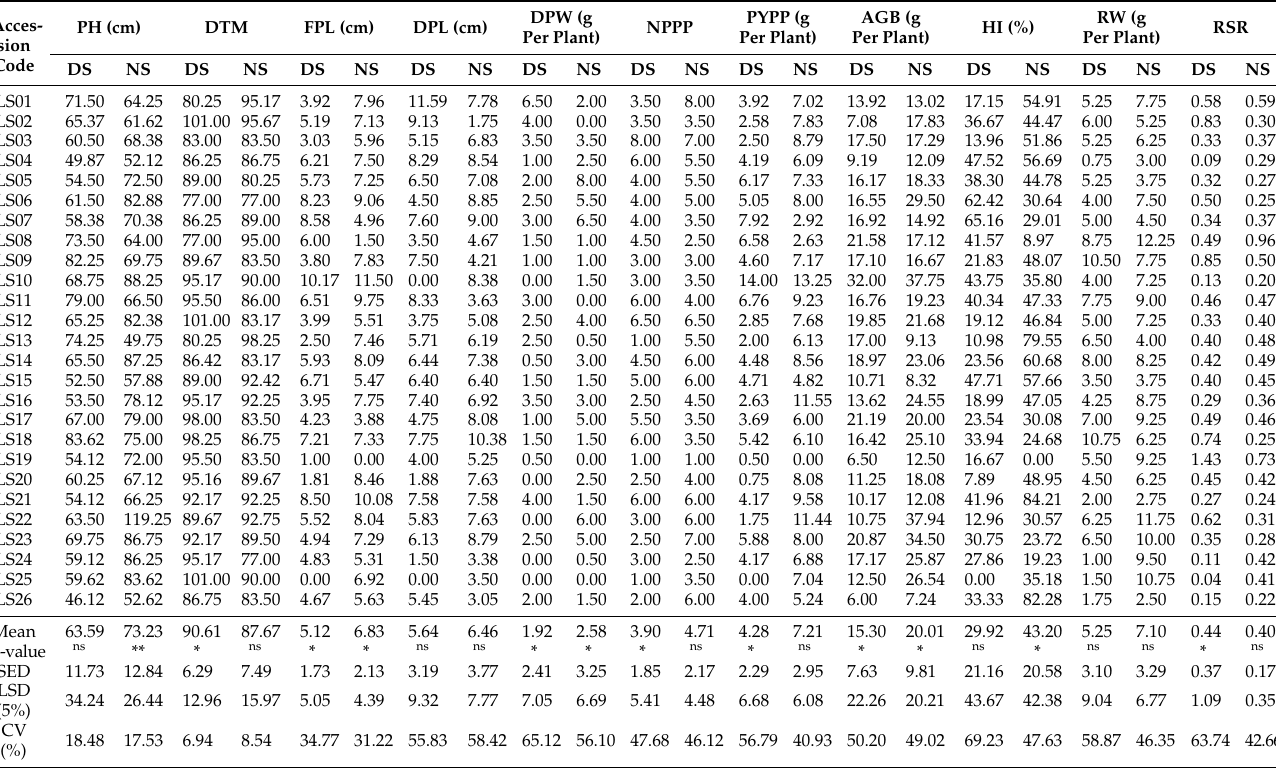
Table 5. Mean values for phenotypic traits among 26 okra accessions evaluated under drought- stressed (DS) and non-stressed (NS) conditions.